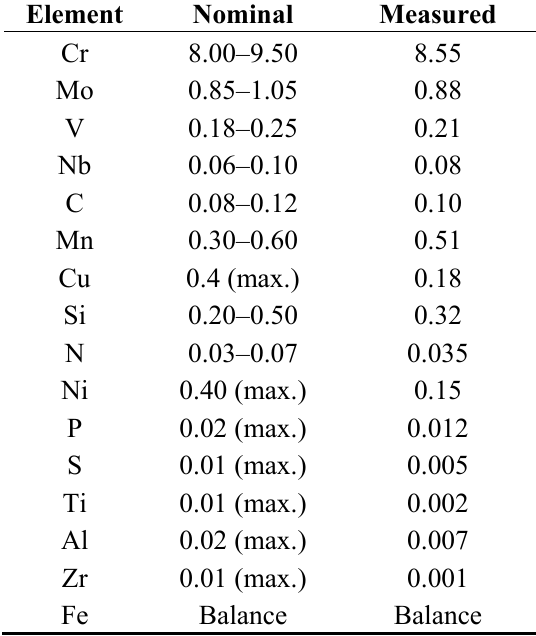
Table 1. Chemical composition (in wt.%) of Grade 91